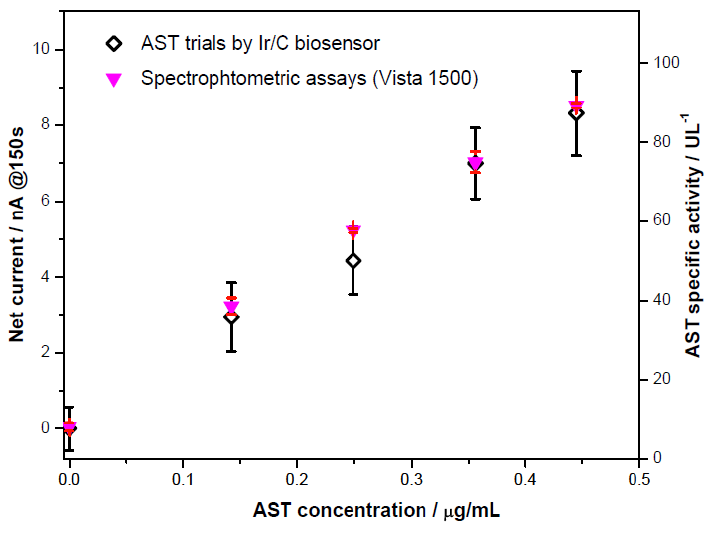
Figure 7. Comparison of measurements achieved by a Vista 1500 spectrophotometer to the Ir-C sensor response currents of human